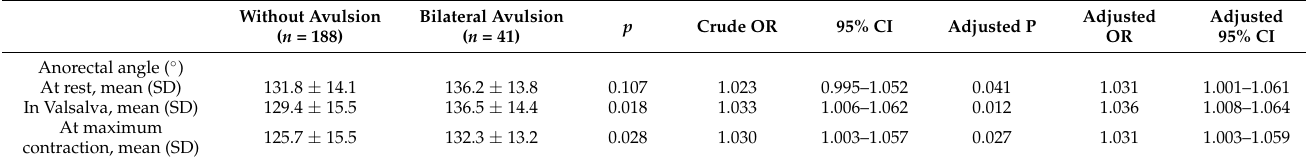
Table 3. The ARA in patients without LAM avulsion and in patients with bilateral LAM avulsion. ORs were adjusted for maternal age in years.